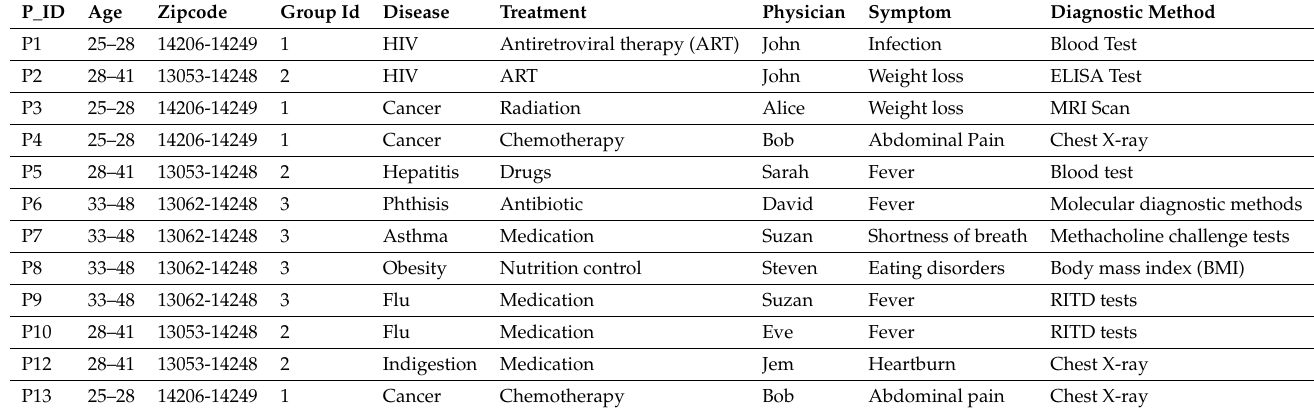
Table 2. Anonymized table